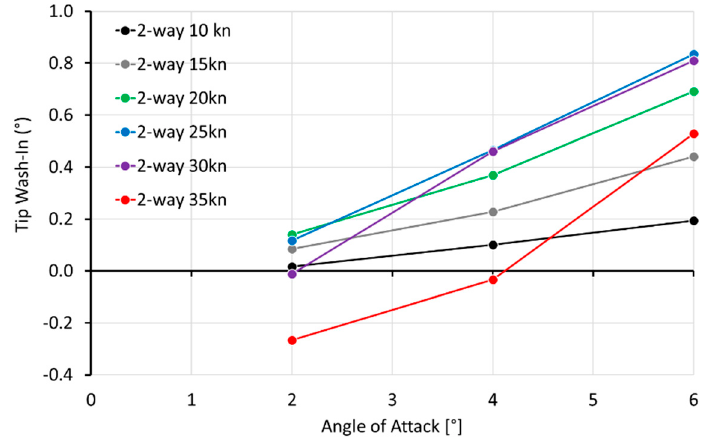
Figure 15. Tip wash-in (negative tip twist) vs. angle of attack.